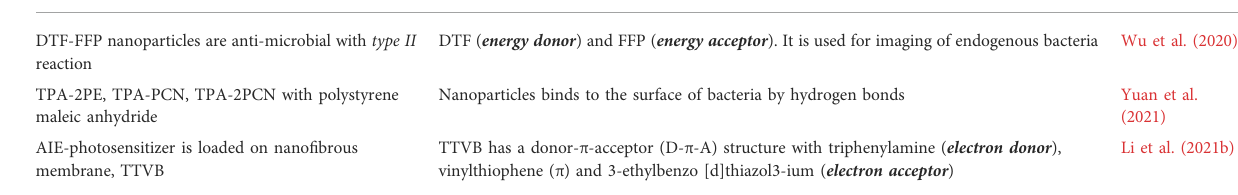
TABLE 5 AIE-photosensitizer nanoparticles for antimicrobial